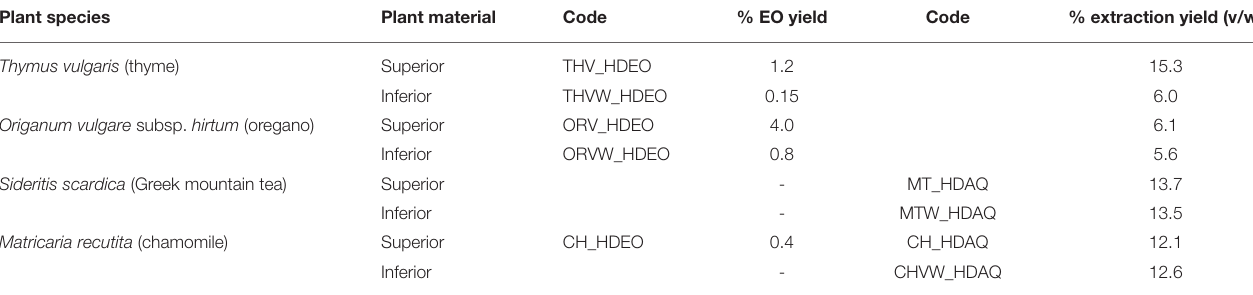
TABLE 5 | Percentage yields of essential oil and aqueous extracts deriving from superior and inferior plant material. Plant